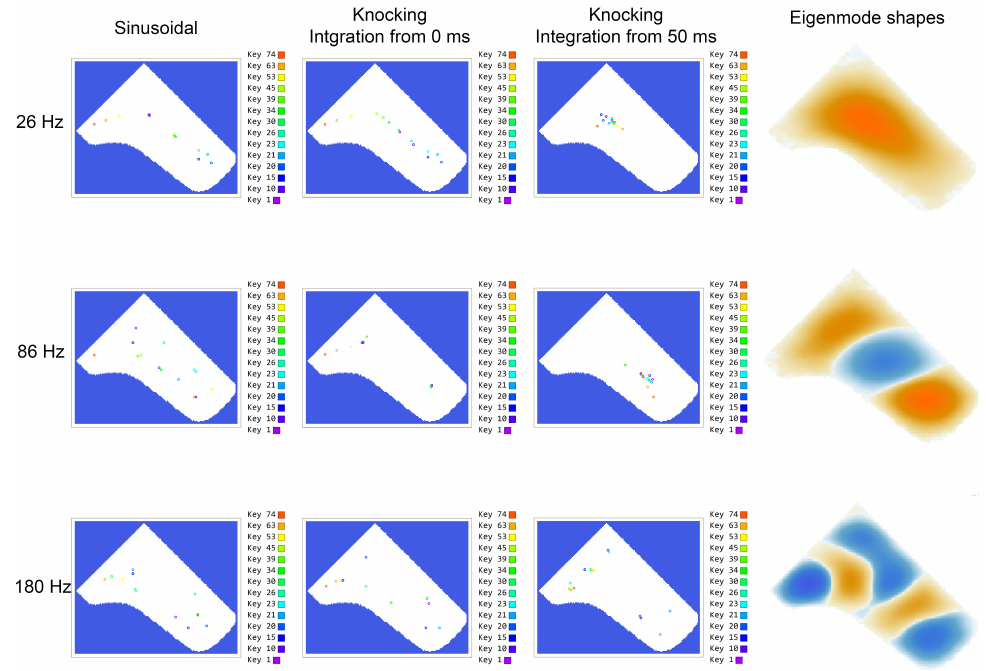
Figure 5. Positions of maximum absolute amplitudes on a raw piano soundboard (first three columns) for 14 driving points (colors) for three different frequencies, top row: 26 Hz, middle row: 86 Hz, bottom row: 180 Hz, with respective modal shapes displayed in the very right column. The left three columns show the maximum amplitude positions for three different conditions: sinusoidal driving (left column), knocking with integration of sound from the very start (second left column), and knocking with integration of sound starting 50 ms after knocking onset. In all cases, the simulation case with minimal damping is displayed. With all three frequencies the very left column shows maximum amplitude positions following the impact positions, where the lowest frequency of 26 Hz follows most clearly. When knocking on the top plate with integration of sound from the very start (second left column), a similar behavior can be seen. Still, when knocking and integrating only after 50 ms after knocking (second right column), the maximum points follow eigenmode patterns, again most clear with 26 Hz and less with higher frequencies. Therefore, eigenmode patterns do appear with piano soundboards, still, when driven with forced oscillations, the vibrational patterns also follow the impact